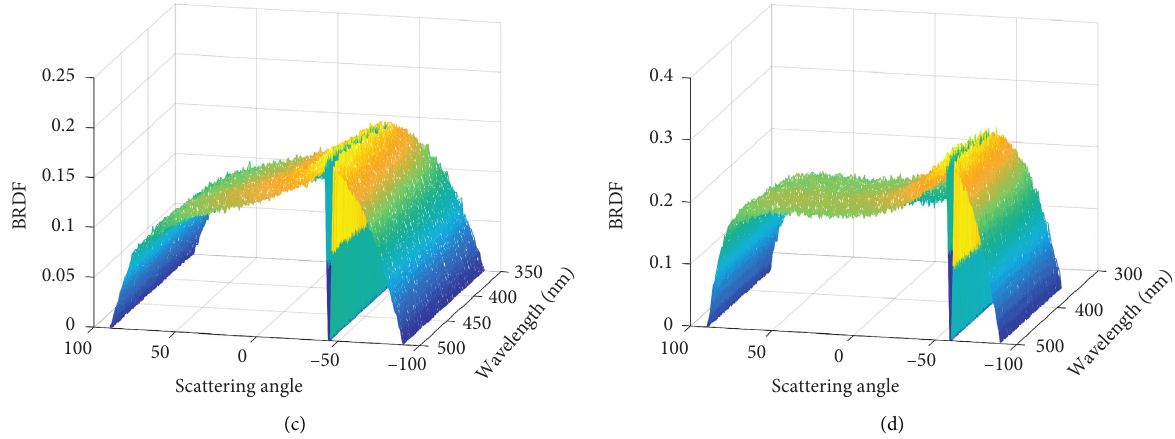
Figure 5: 3D graph of sample 2. (a) 3D data of 0 ° incident angle; (b) 3D data of 30 ° incident angle; (c) 3D data of 45 ° incident angle; (d) 3D data of 60 ° incident angle.